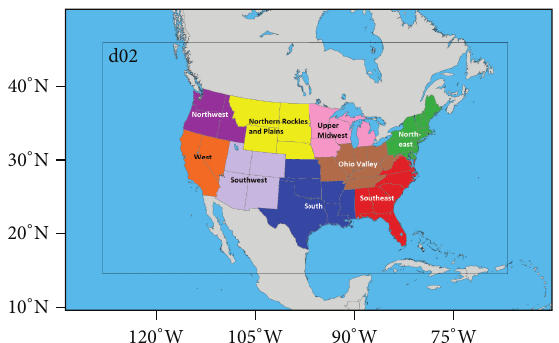
Figure 1: WRF 108-km and 36-km (“d02”) domains. Shaded regions are the NCDC climate